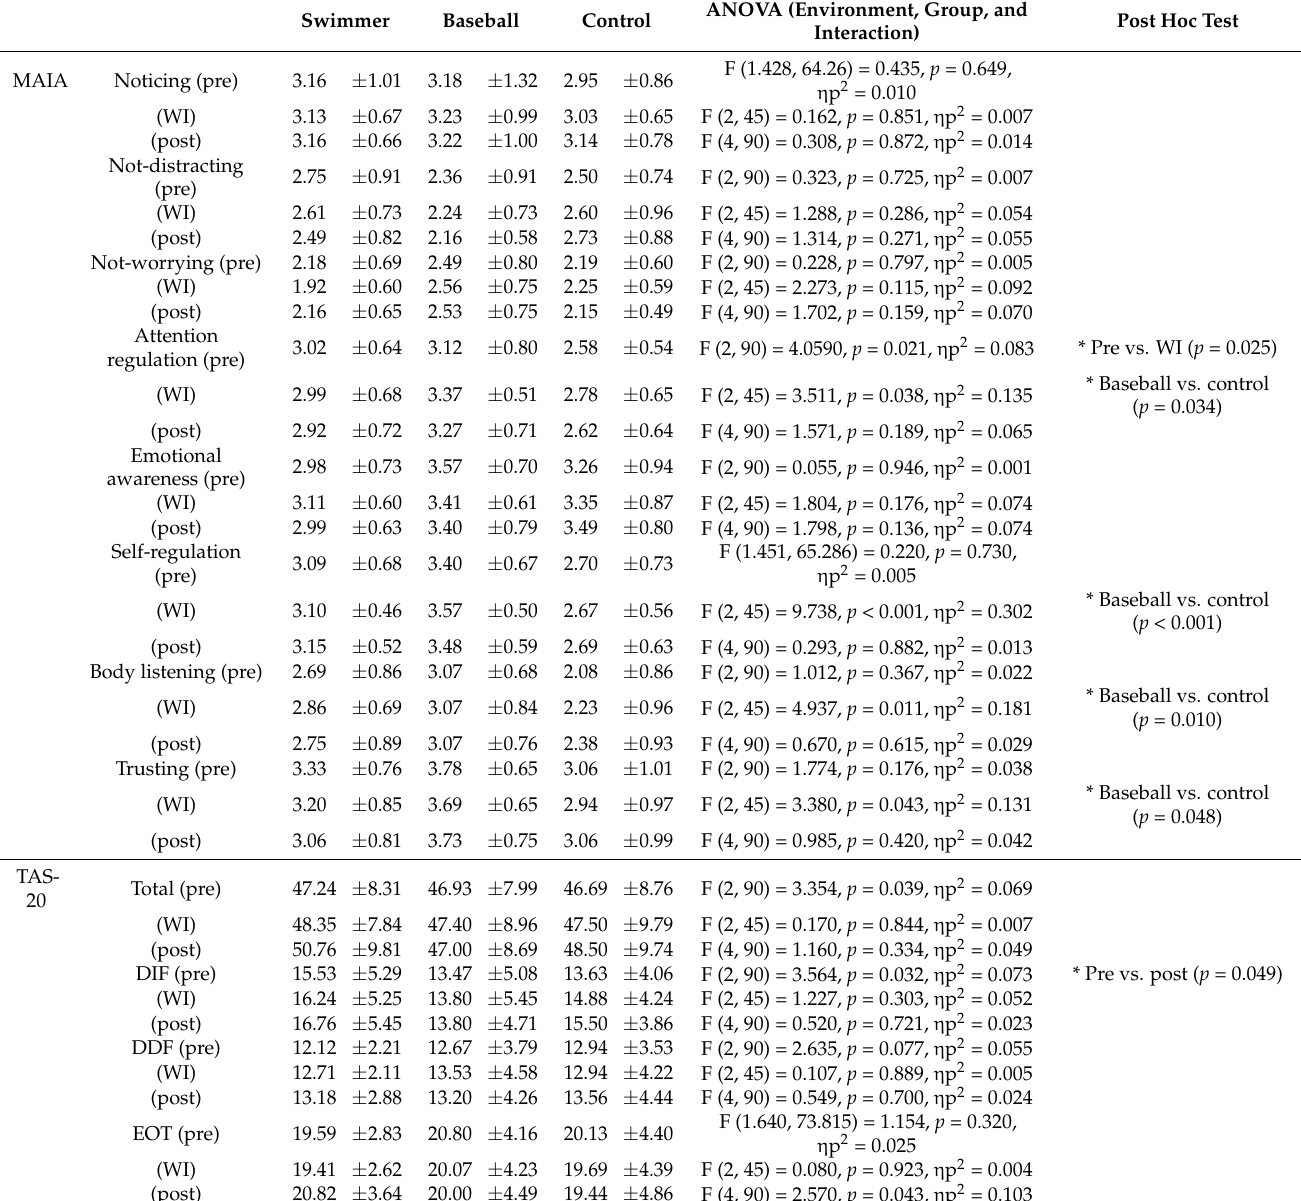
Table 1. The Multidimensional Assessment of Interoceptive Awareness (MAIA) and the 20-item Toronto Alexithymia Scale (TAS-20). Swimmer Baseball Control